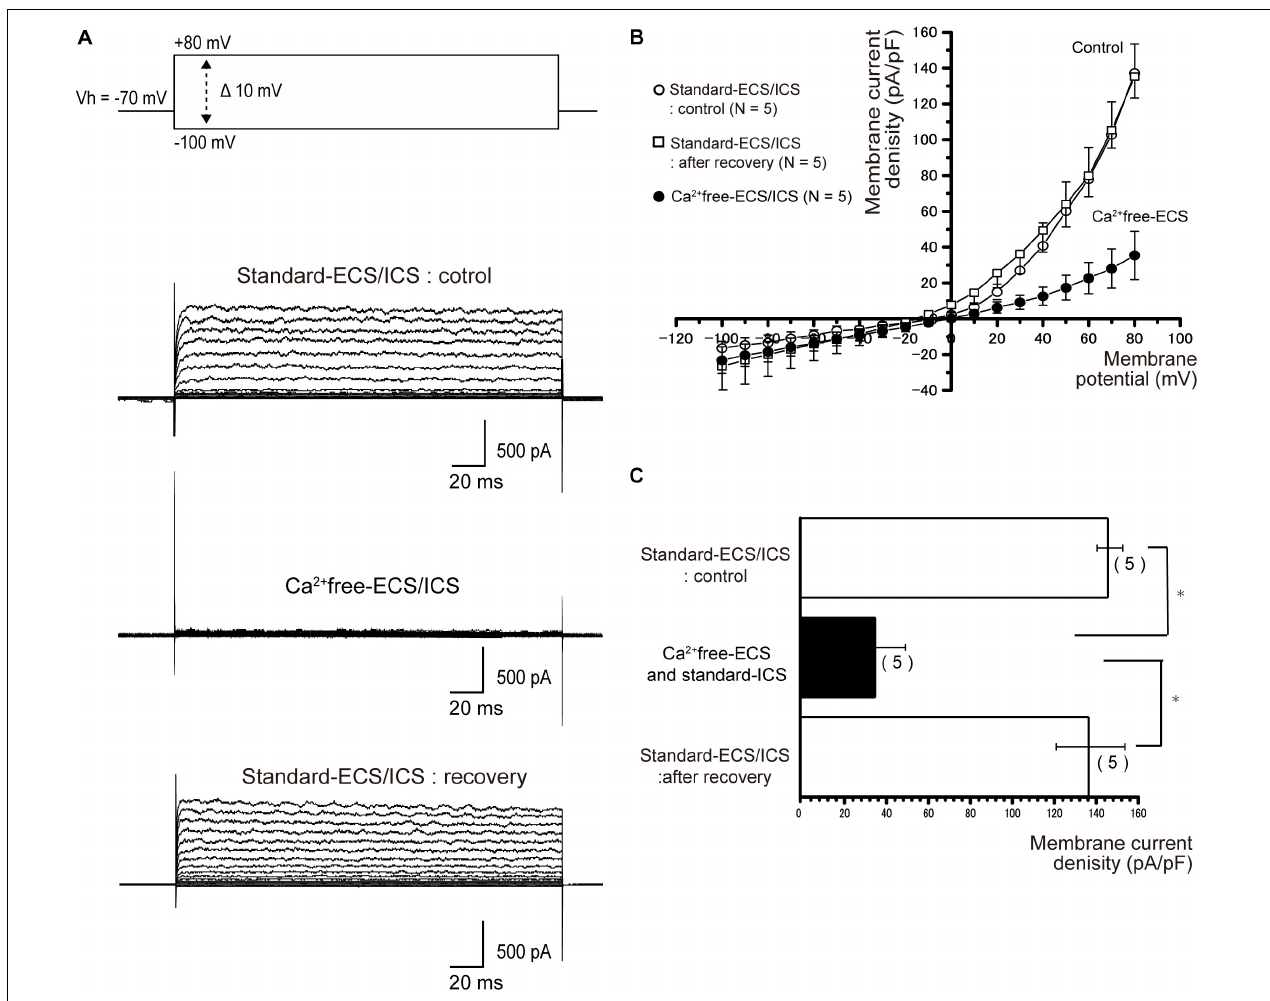
FIGURE 4 | Outward currents were extracellular Ca 2 + sensitive. (A) To examine Ca 2 + -dependent processes in the activation of outward currents, extracellular Ca 2 + was eliminated (Ca 2 + free-ECS). The currents were elicited by applying (400 ms) voltage in 10 mV increments from –100 mV to +80 mV at a holding potential (Vh) of –70 mV. The second upper traces show the currents recorded from the standard-ECS/ICS, the second lower traces show those based on the Ca 2 + free-ECS/standard-ECS, and the lower traces represent those after extracellular Ca 2 + was restored. (B) Current-voltage (I-V) relationships for the currents recorded with the standard-ECS/ICS (open circles), Ca 2 + free-ECS and standard-ICS (filled circles), and after recovery. Points represent the mean ± SE current density of five cells. When we subtracted the current amplitudes in the Ca 2 + free-ECS from those obtained in the standard-ECS, the conductance of the pure Ca 2 + -activated currents was 293 pS. (C) Summary bar graph showing the current densities at a membrane potential of +80 mV, under the conditions of the standard-ECS/ICS (upper column), Ca 2 + free-ECS and standard-ICS, and standard-ECS/ICS as recovery. Statistically significant differences are indicated by asterisks, ∗ P <